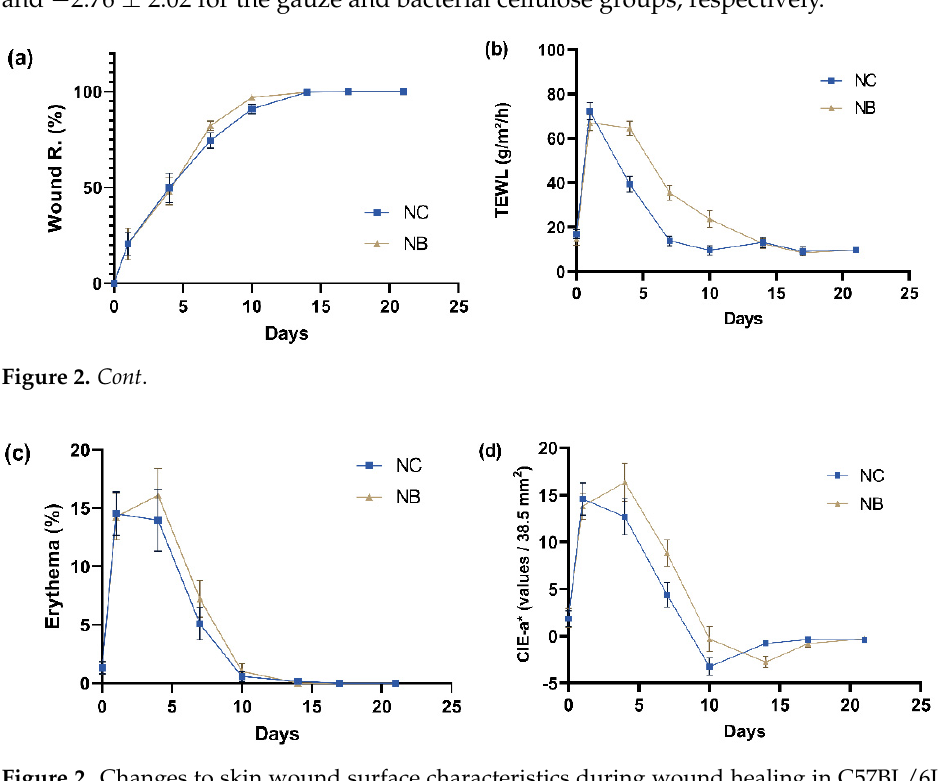
Figure 2. Changes to skin wound surface characteristics during wound healing in C57BL/6JNarl mice. Mouse groups were respectively treated with gauze (NC, n = 12) and bacterial cellulose (NB, n = 12) after wounding. The changes in ( a ) Wound R., ( b ) TEWL, ( c ) erythema, and ( d ) CIE-a* values were detected by a skin analyzer on different days. Bars, means of triplicates ± S.D.